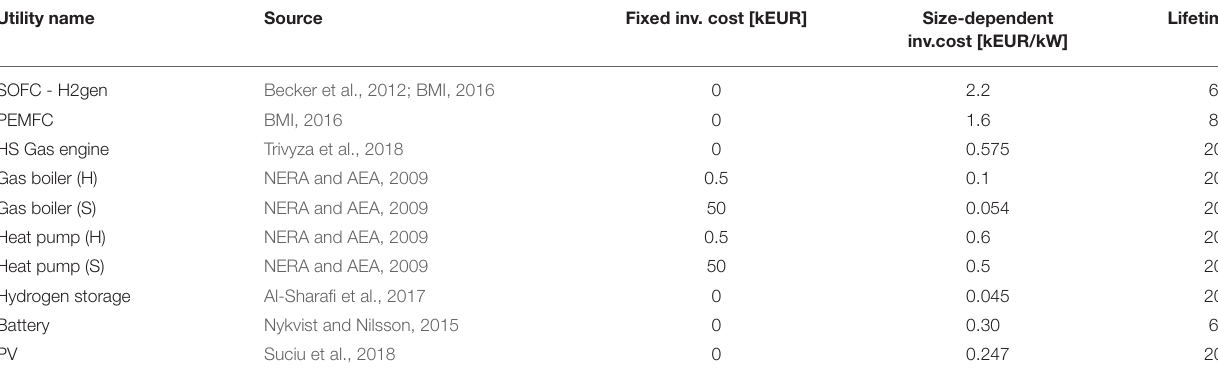
TABLE 2 | Cost coefficients and expected lifetime for the investigated utilities. Utility